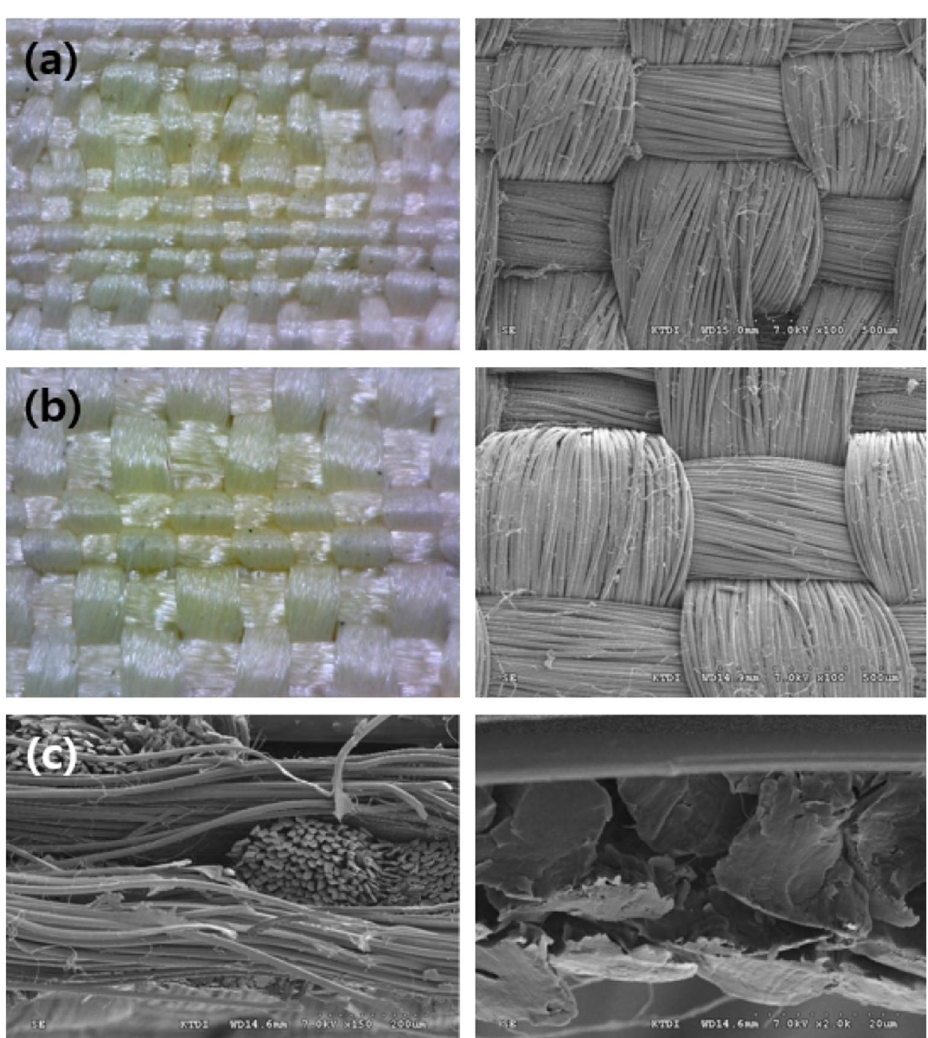
Figure 8. Para-aramid fabric. (a) 100 × magnified image of the surface of the fabric, (b) 100 × magnified image of the rear side of the fabric, (c) 150 and 2000 × magnified image of the cross section of the fabric.